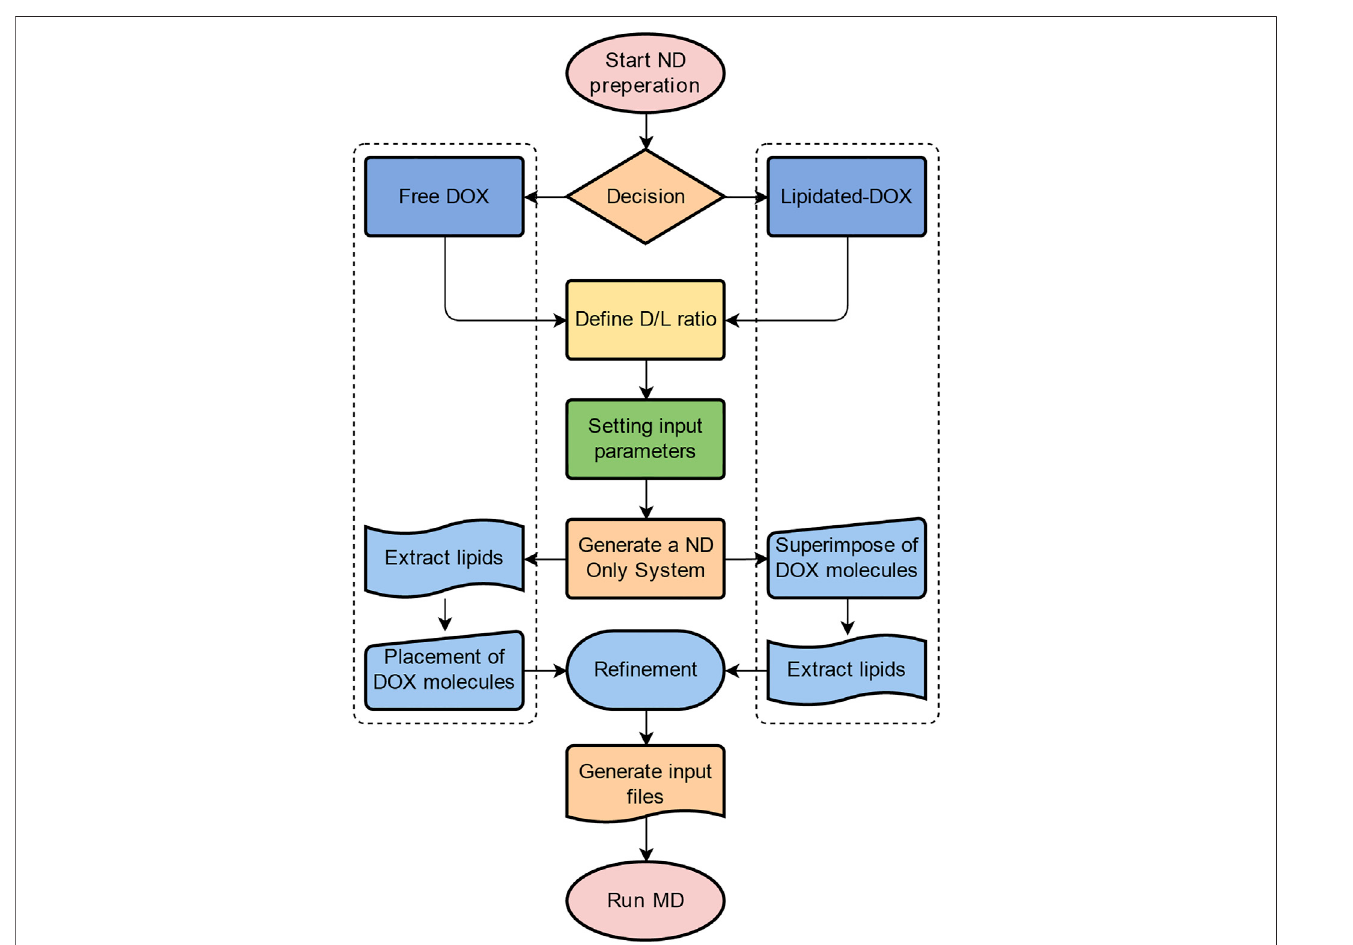
FIGURE2 | MDsimulationresultsoffree-DOXincorporatedDPPCNDformulation.TheRMSDtrajectoryofDPPC,MSP1,andNDcomplexasafunctionofsimulationtime innanoseconds(ns) for (A) theempty ND, (B) 10%DOX-ND, (C) 25% DOX-ND,and (D) 50%DOX-ND. (E) TheRMSDtrajectoryofDOX moleculeswith increasingproportions (10,25,and50%)asafunctionofsimulationtimeinns.Theinitialand fi nalsnapshotofthesimulationforeachDOX-NDformulation: (F) 10%DOX-ND, (H) 25%DOX-ND,and (J) 50% DOX-ND. The interactions of the DOX molecules with the ND differed depending on the proportions of DOX: (G) 10% DOX, (I) 25% DOX, and (K) 50% DOX.